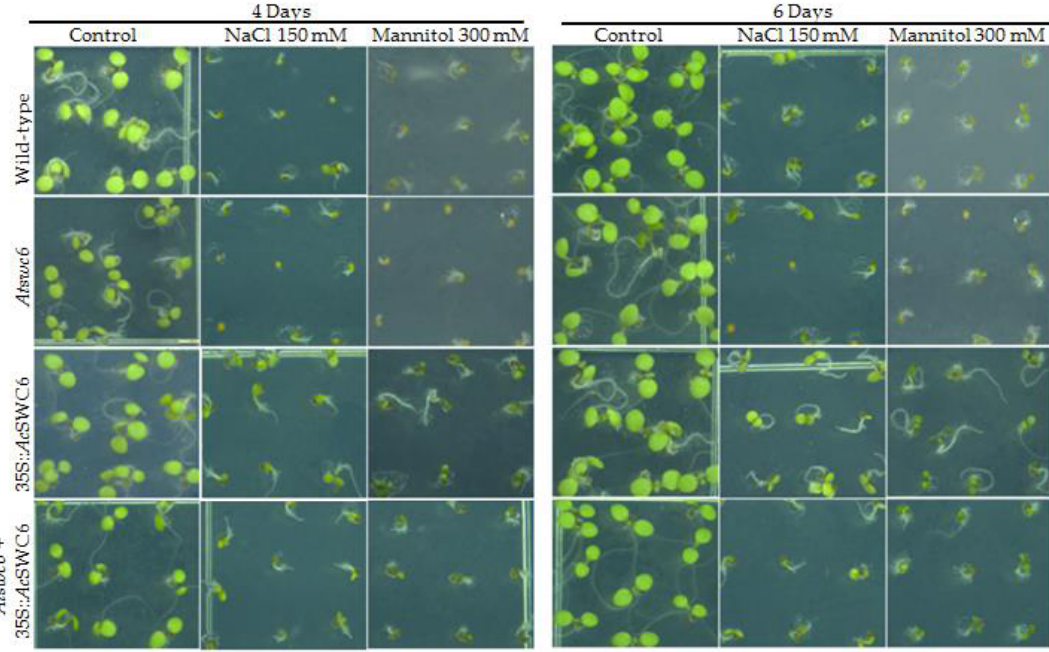
Figure 8. Overexpression of Ac SWC6 results in resistance to salinity and osmotic stress. Phenotype of 4 days and 6 days old wild type, Atswc6 , 35S:: Ac SWC6 and complemented line germinated under salinity (150 mM NaCl) and osmotic stress (300 mM mannitol).